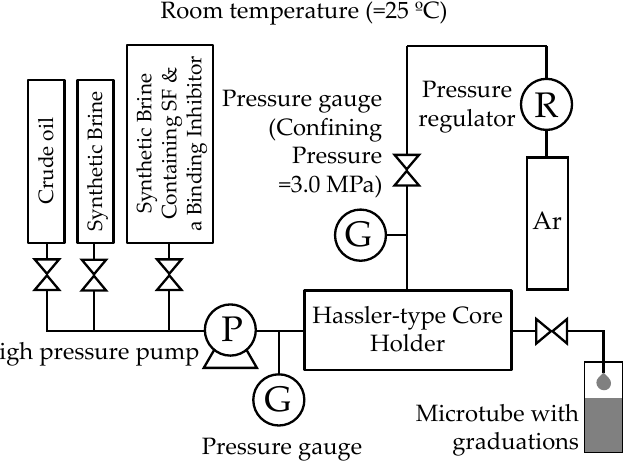
Figure 2. Schematic image of the core flooding system used in this study.